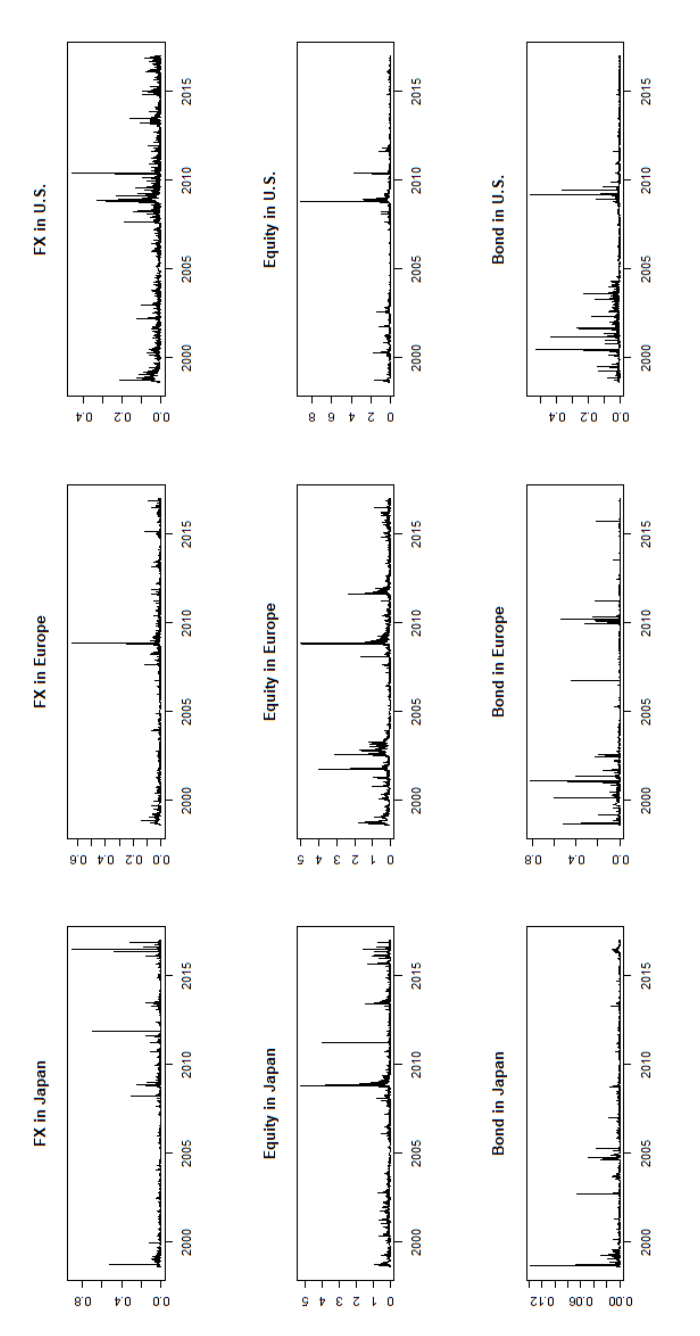
Figure 1. Minimum realized volatility estimates (scaled by 1000) for foreign exchange, equity and bond markets in Japan, Europe and